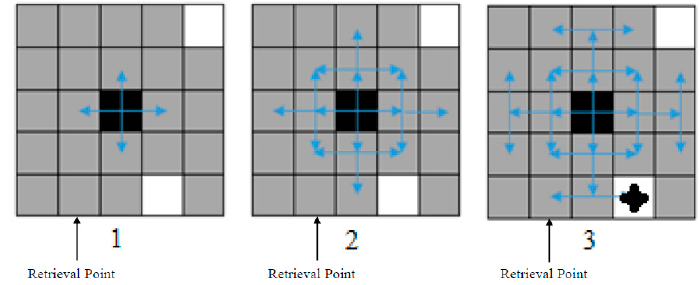
Figure 4. An example of message ‐ passing algorithm.